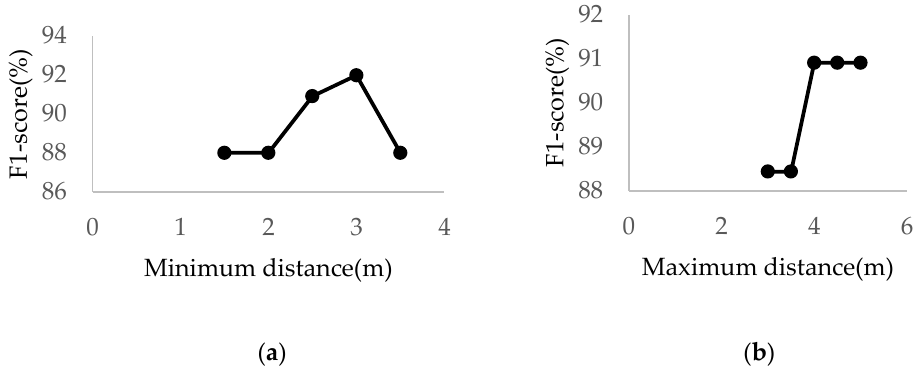
Figure 15. F1-score values corresponding to the minimum and maximum distances of different buffers: ( a ) Minimum distance; ( b ) Maximum distance.